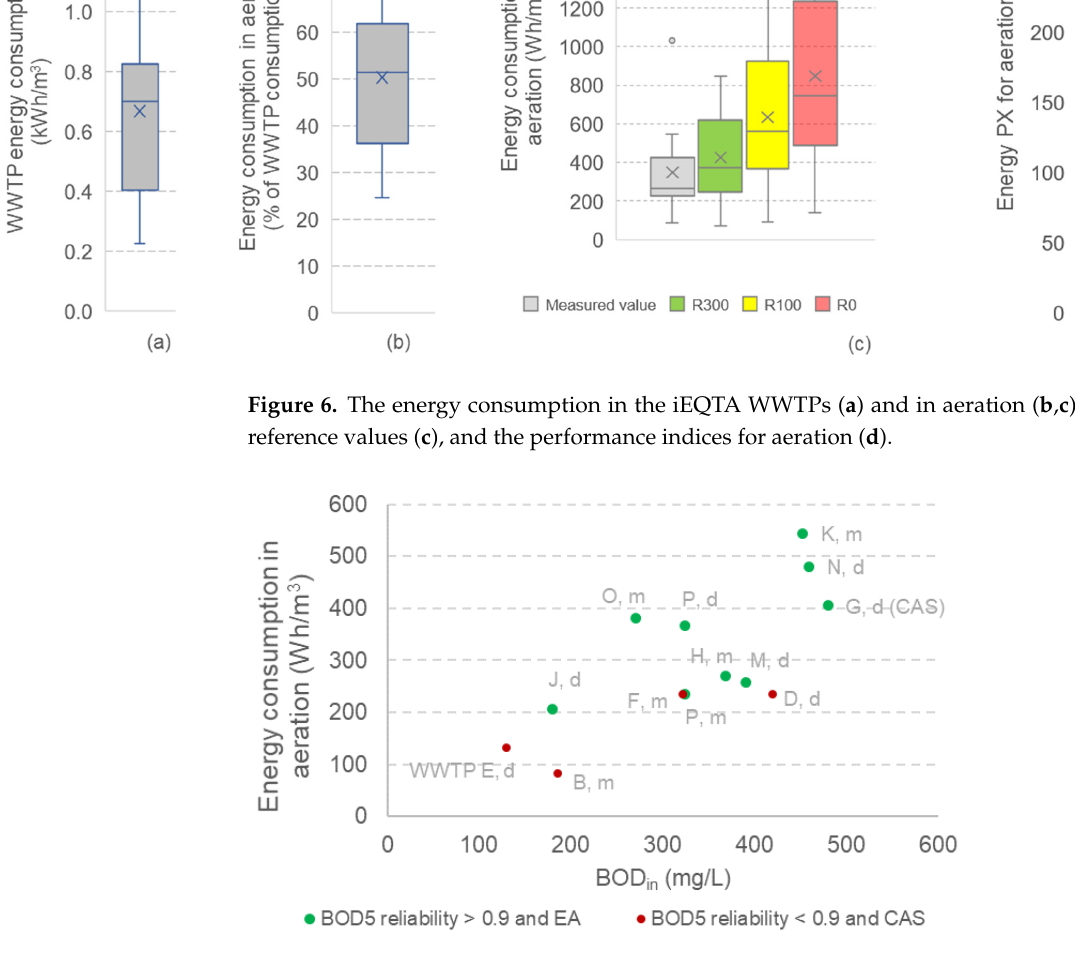
Figure 7. The energy consumption for aeration vs. influent BOD 5 in the iEQTA WWTPs with BOD 5 reliability lower and higher than 0.9 (daily values from the energy-measurement campaigns).